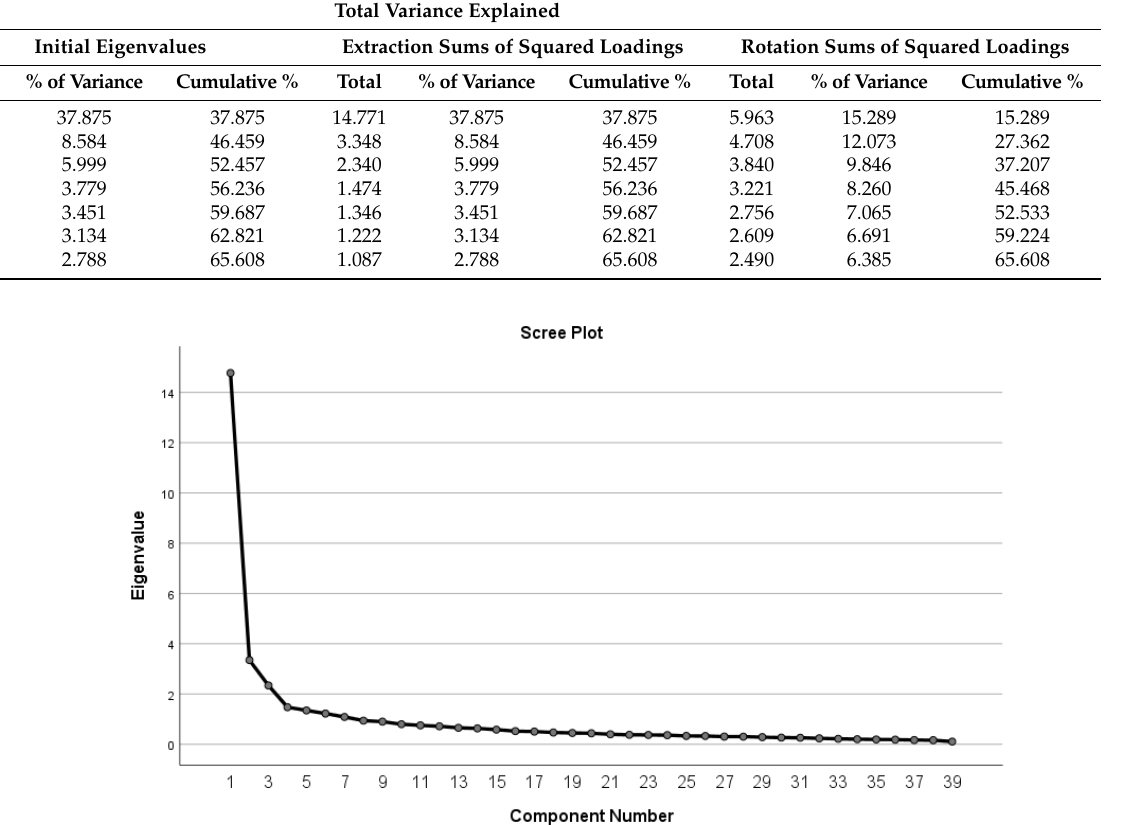
Table 11. Exploratory factor analysis results for the university library space user experience questionnaire: total variance results.